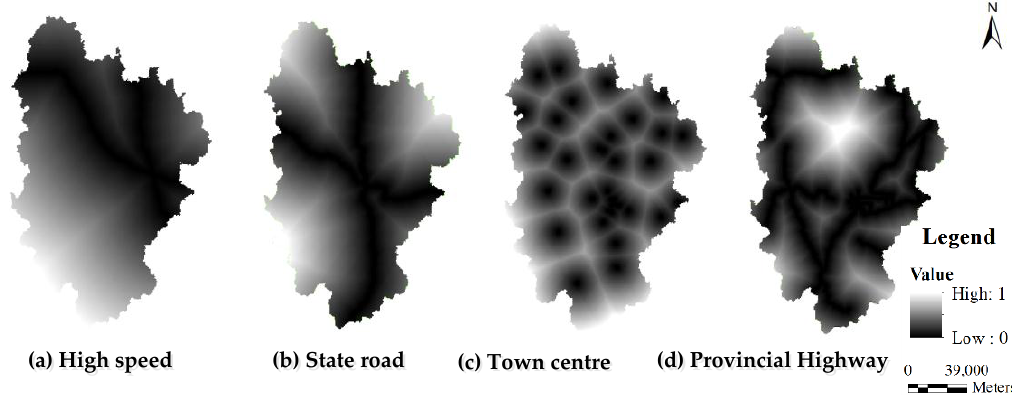
Figure 4. The map of the distance between the primitive cells and various related factors.